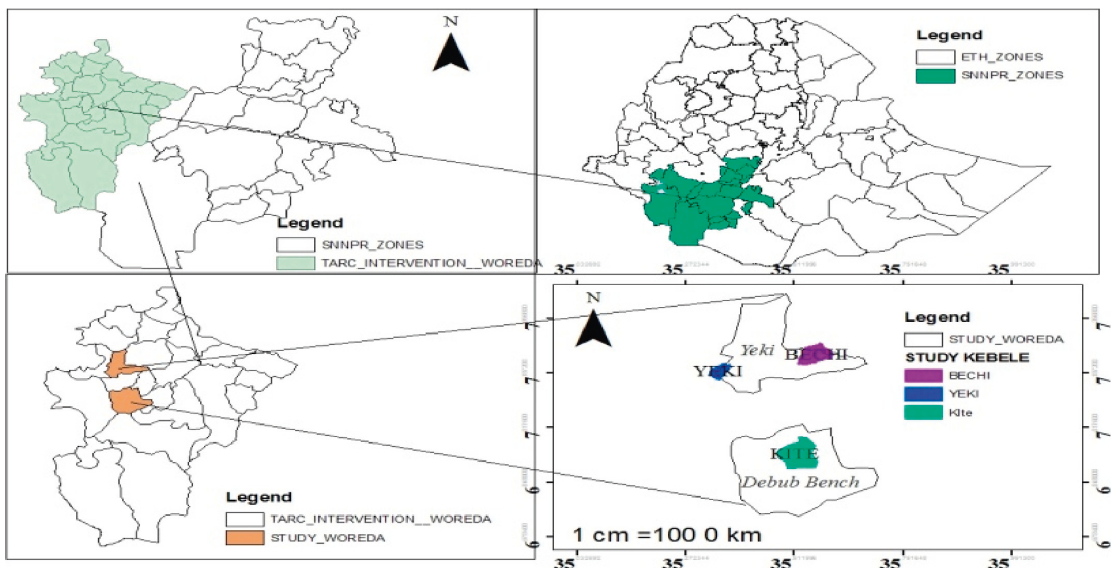
Figure 1: Map of Ethiopia showing Bench Maji and Sheka zones including the experimental sites Tepi, Bechi, and Kite kebeles. Table 1: Description of the study